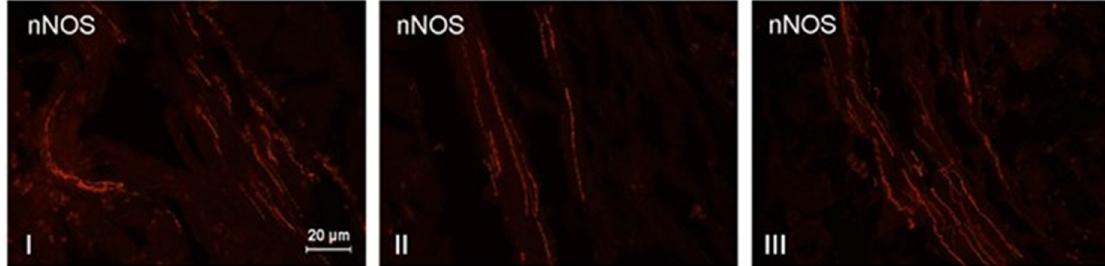
Figure 2. Intramuscular nerves in the colonic wall immunoreactive to nNOS (red) in the control animals ( I ), “sham” operated animals ( II ), and animals with inflammation ( III ).